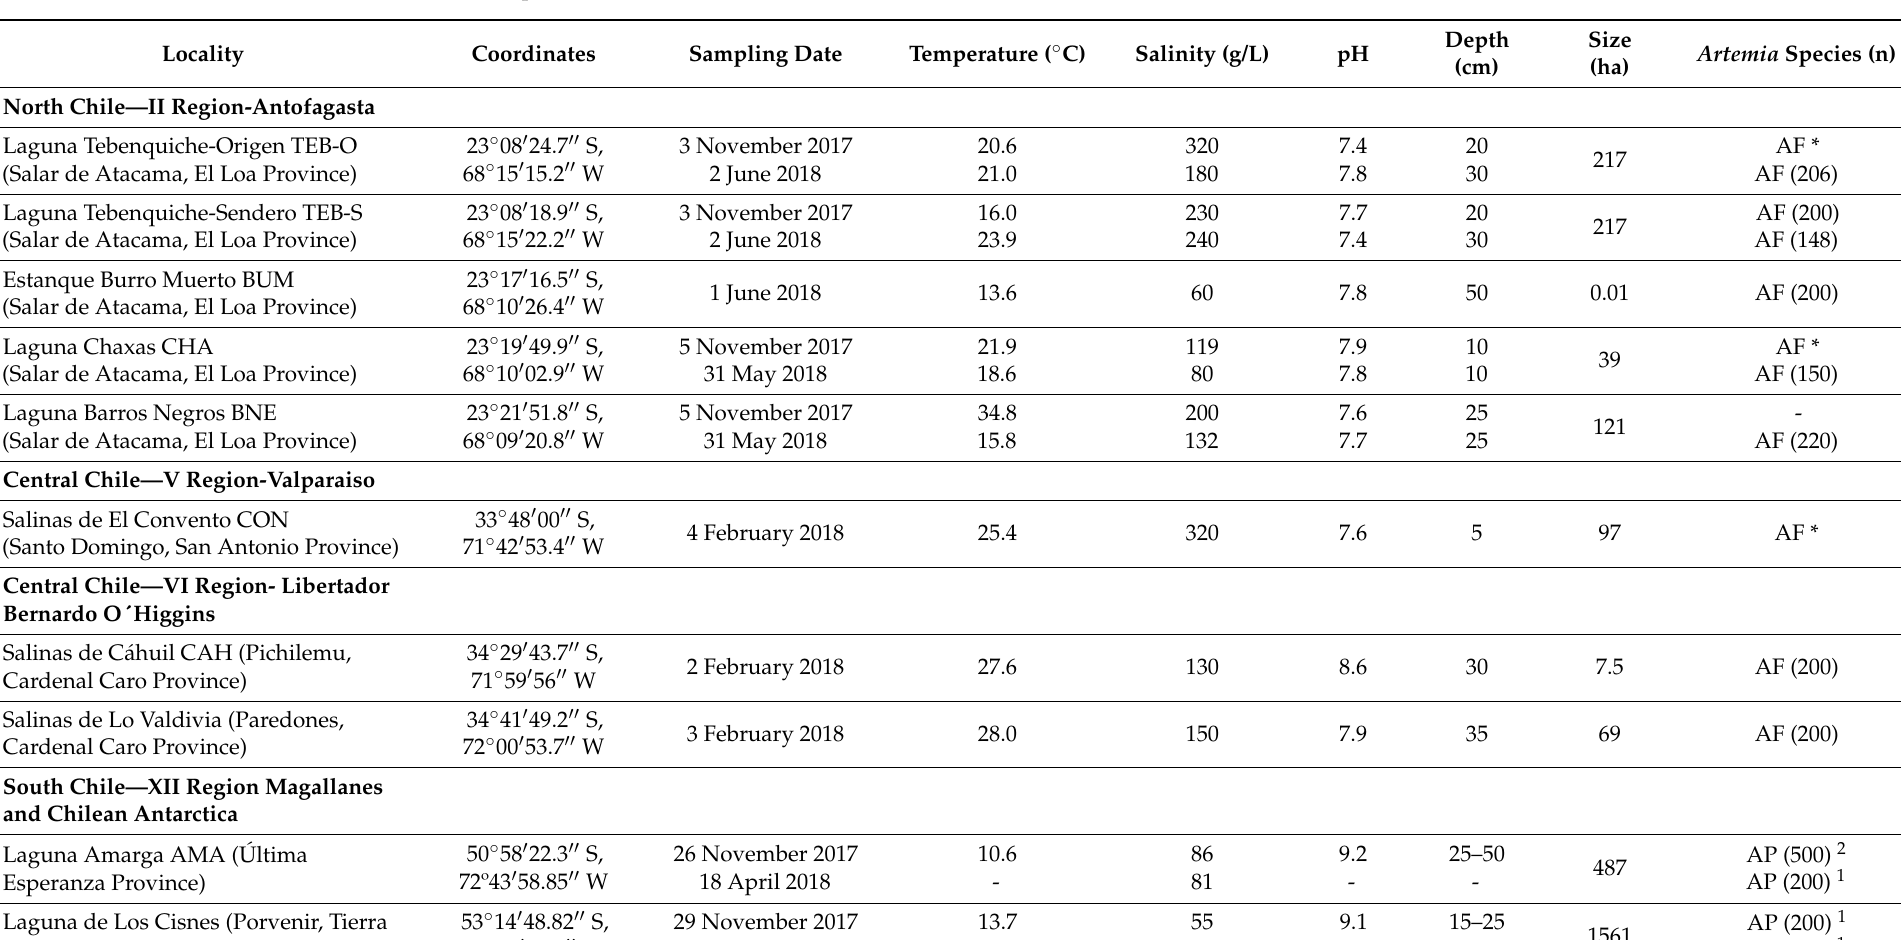
Table 1. Artemia samples and study localities, indicating geographical coordinates, sampling date, temperature, salinity, and pH. Artemia species (AF, A. franciscana ; AP, A. persimilis ) and number of individuals examined (n) in each sample are also